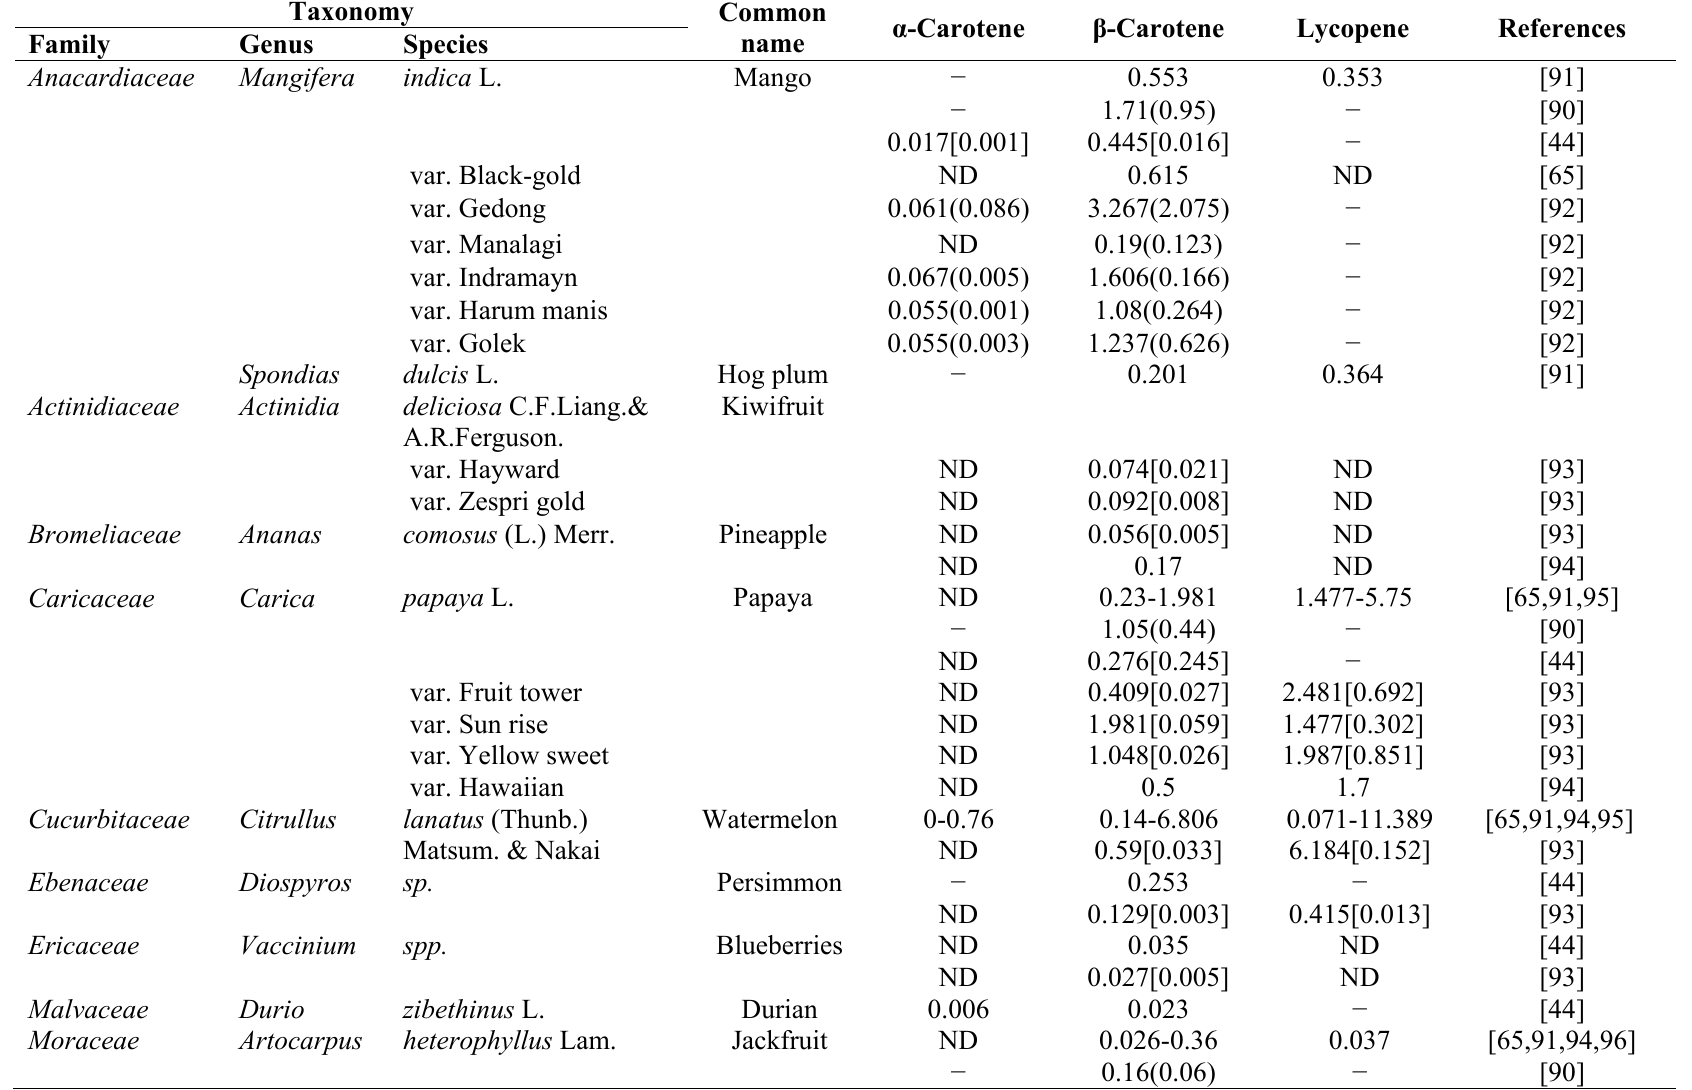
Table 2. Carotenoid contents (mg/100 g fresh weight) of some common